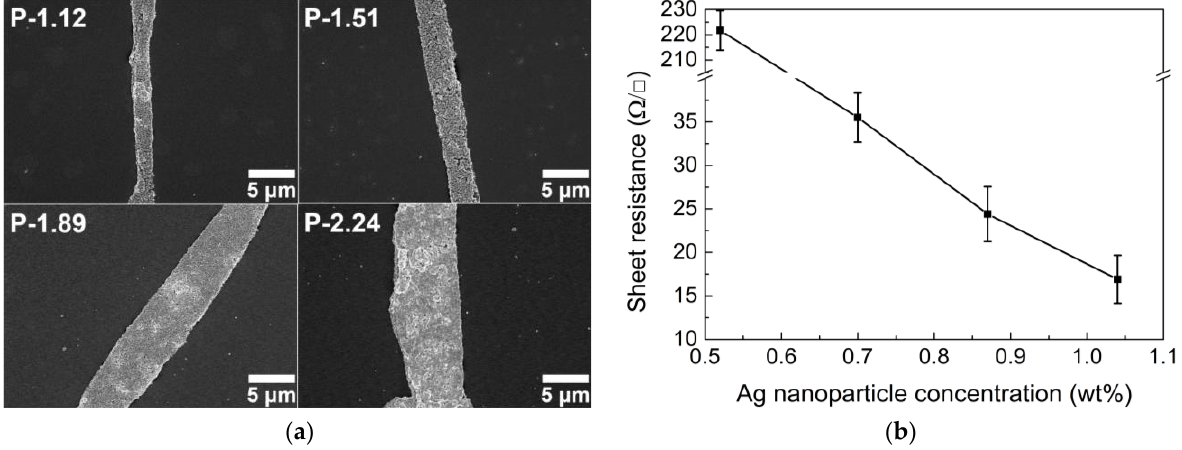
Figure 3. ( a ) SEM images of conductive lines in TCFs and ( b ) sheet resistance with different concen- tration of Ag nanoparticles.